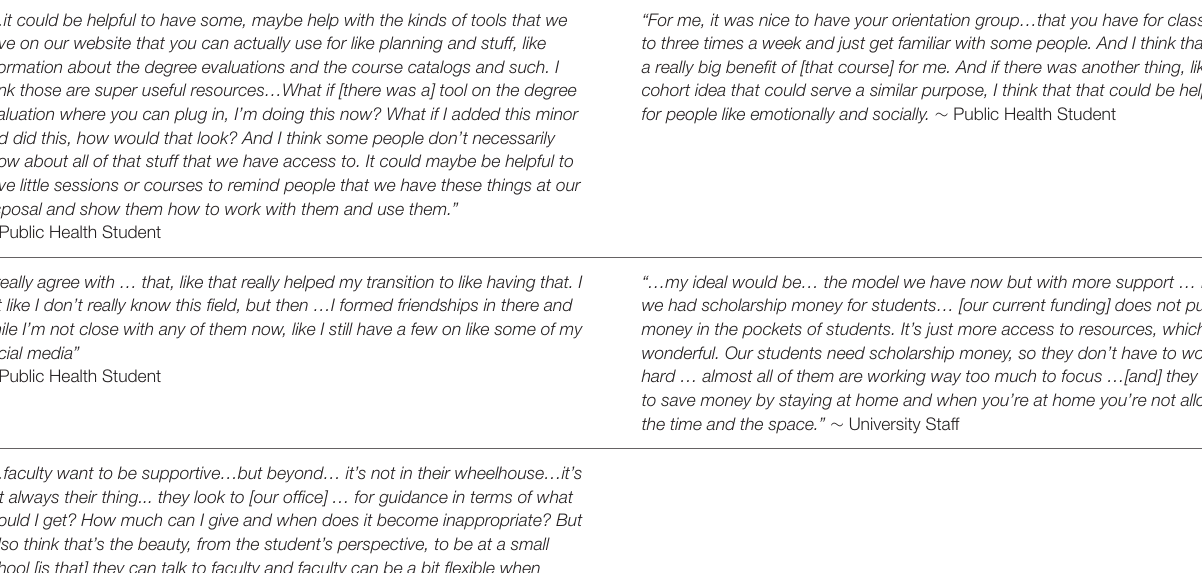
“For me, it was nice to have your orientation group…that you have for class two to three times a week and just get familiar with some people. And I think that was a really big benefit of [that course] for me. And if there was another thing, like the cohort idea that could serve a similar purpose, I think that that could be helpful for people like emotionally and socially. ∼ Public Health